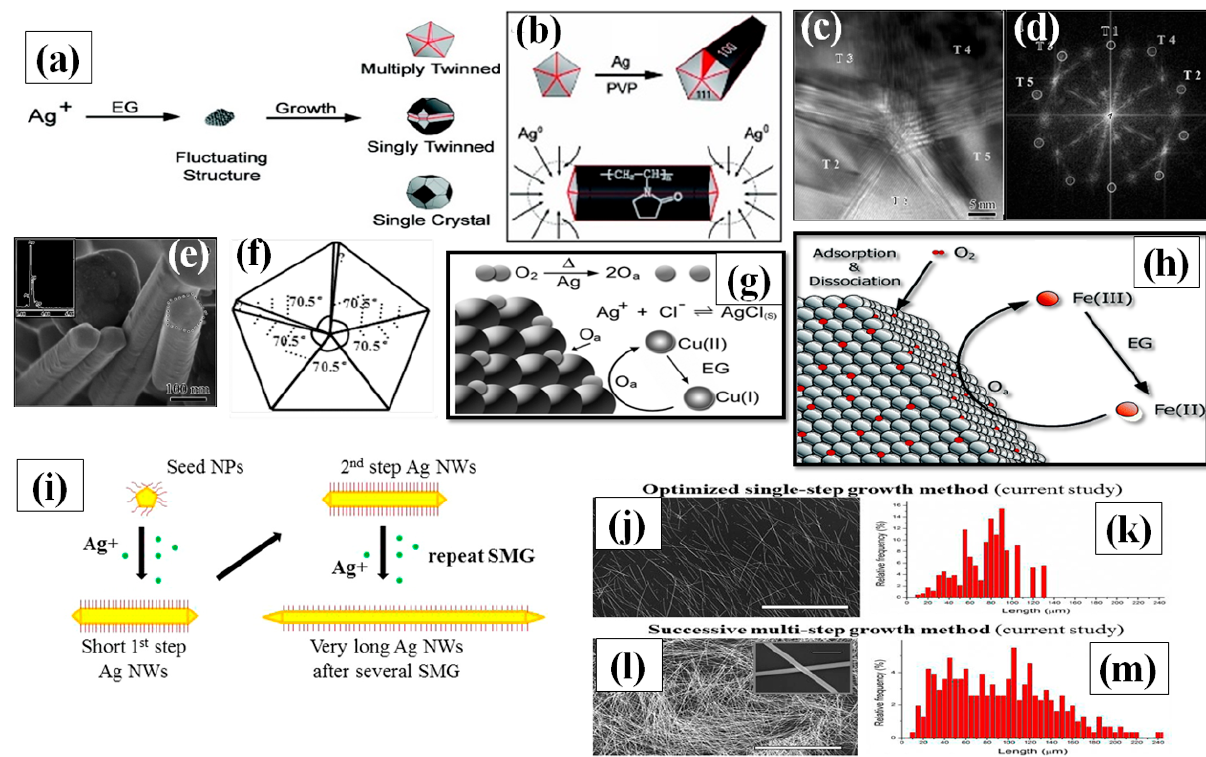
Figure 5. ( a ) the process of Ag + reduction and various types of seeds (multiply twinned, singly twinned, or single-crystal) formation in polyol method. Therefore, one must regulate the crystallinity of the seeds in a reaction to produce a specific shape. ( b ) Once twinned decahedral seeds lengthened into rods. PVP selectively adsorbed on the {100} side facets so that Ag atoms could only add to the {111} facets at the ends of each rod (adapted from [90] with permission from ACS publications, 2007). ( c ) HRTEM image of the center area of an Ag cross-section showing five distinctive {111} twinning boundaries, (scale bar 5 nm). ( d ) FFT image of Figure 5c ( e ) pentagonal profiles of the nanorods formed in initial stage of synthesis. The inset shows the EDX data from a nanorod. ( f ) Pentatetrahedral twin model for an Ag nanorod formation in initial stage (adapted from [97] with permission from ACS publications, 2004). ( g ) A schematic illustration depicting the role of Cu-containing salts in the polyol synthesis of AgNWs has been shown. Oxygen present during initial seed formation can adsorb and dissociate on the Ag seeds, blocking sites for further Ag deposition. Cu (I) rapidly scavenges this adsorbed atomic oxygen (O 2 ), with the Cu(I) being oxidized to Cu(II). Ethylene glycol (EG) reduces the Cu(II) back to Cu(I), providing a constant means for oxygen removal (adapted from [88] with permission from Royal Society of Chemistry, 2008) ( h ) The same mechanism Illustration of Fe-salt to removes atomic oxygen ref. (adapted from [89] with permission from ACS publications, 2005) ( i ) illustration of polyol process and a successive multistep growth process ( j , k )) long AgNWs by an optimized single step growth conditions developed ( l , m ) very long AgNWs by the successive multistep growth (SMG) optimized process. All scale bars in SEM images are 100 µm and a scale bar in inset of panel L is 4 µm (adapted from [102] with permission from ACS publications, 2012).